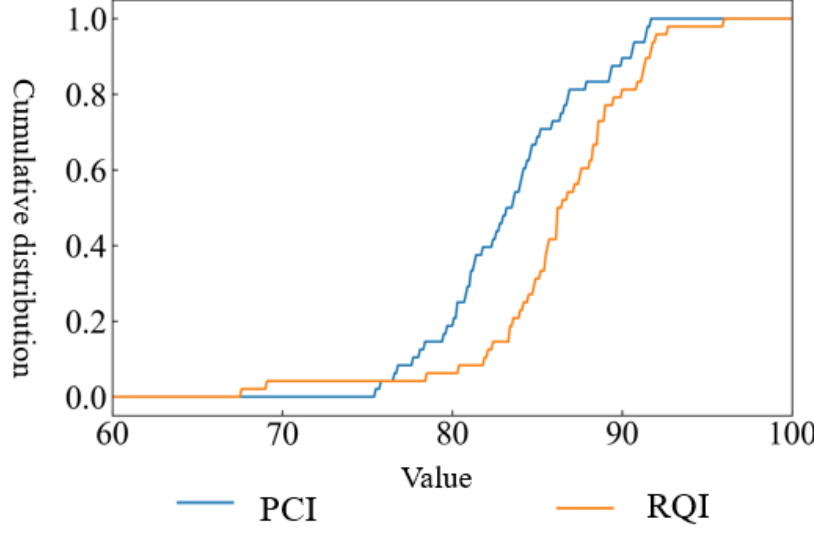
Figure 9. Continuity function diagram of the cumulative distribution of PCI and RQI.